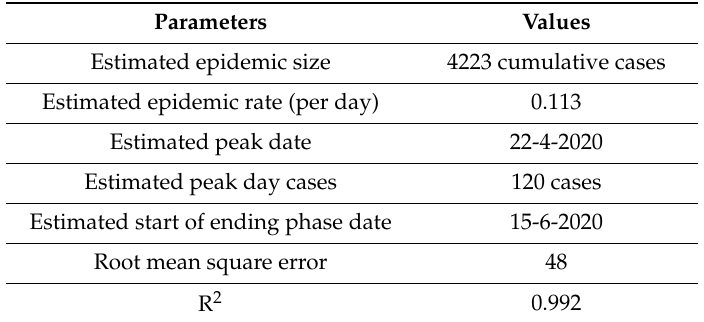
Table 3. Estimated simulation results of the logistics regression model.